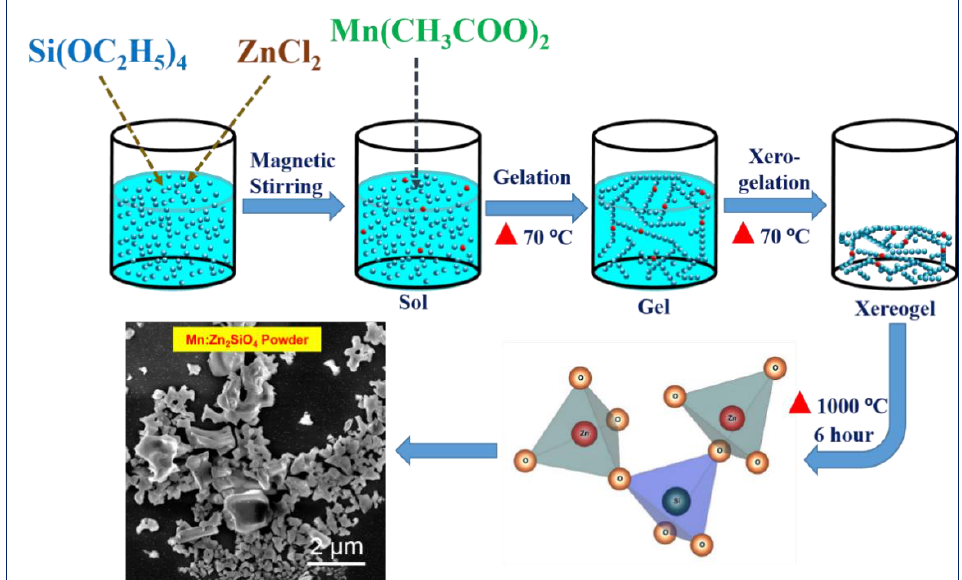
Figure 1. Schematic diagram of sol – gel method for the synthesis of Mn-doped Zn 2 SiO 4 green phosphor nanoparticles. Red triangle corresponds to heating.